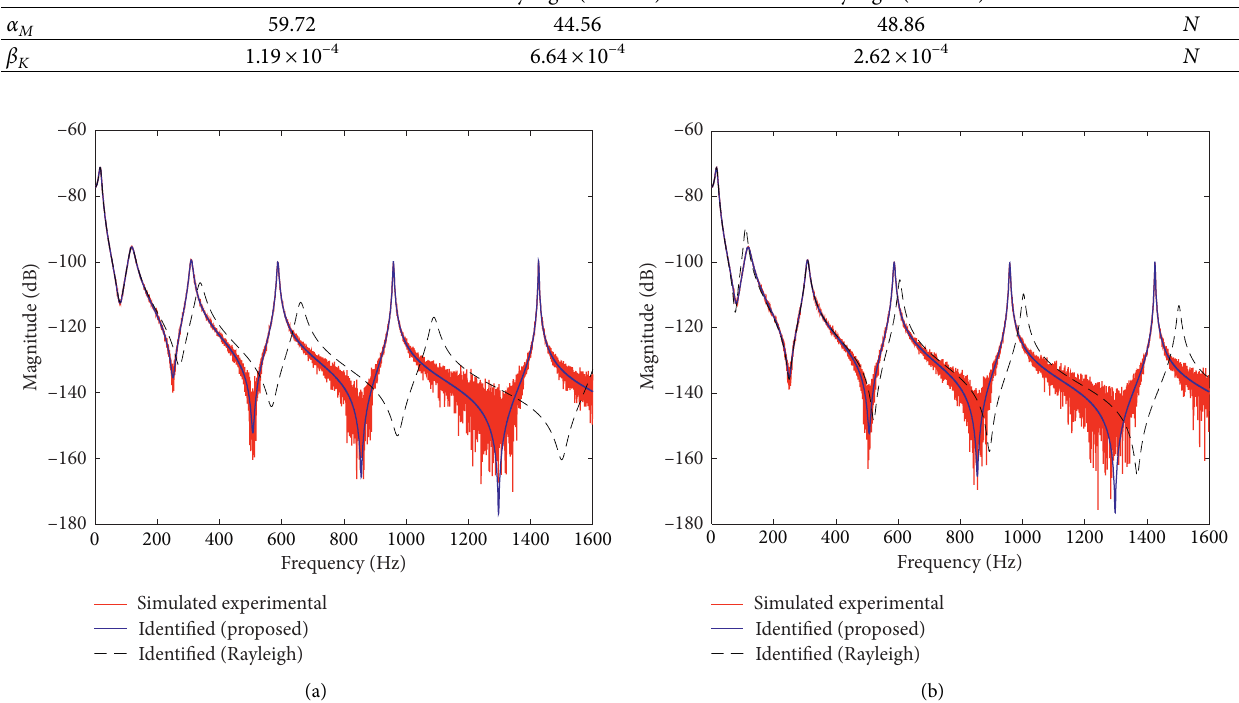
1,1 for case 1. (a) Rayleigh (1 and 2). (b) Rayleigh (1 and